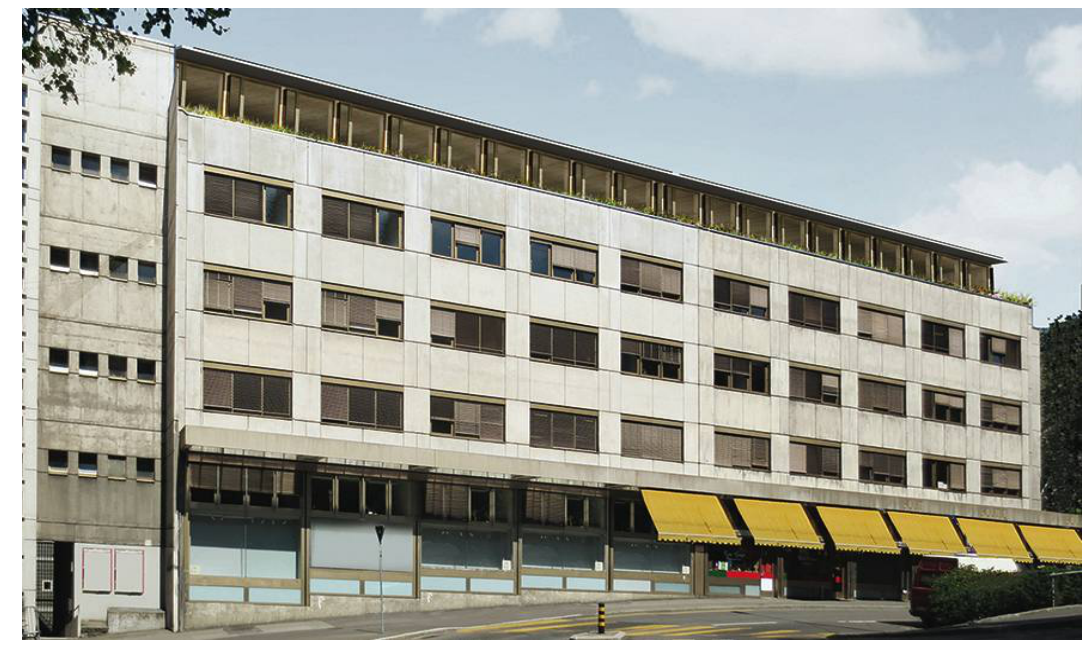
Figure 7. Visualisation of the vertical extension from the street.